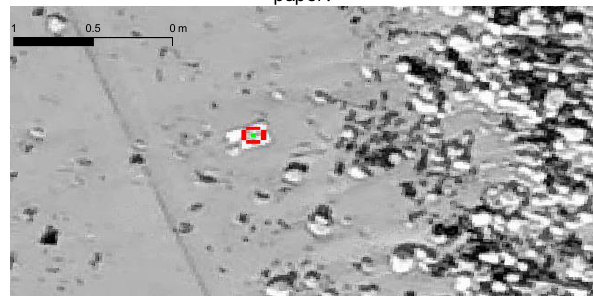
Figure 4: The same target with a display of the original GPS point. (grey scale has been chosen for better